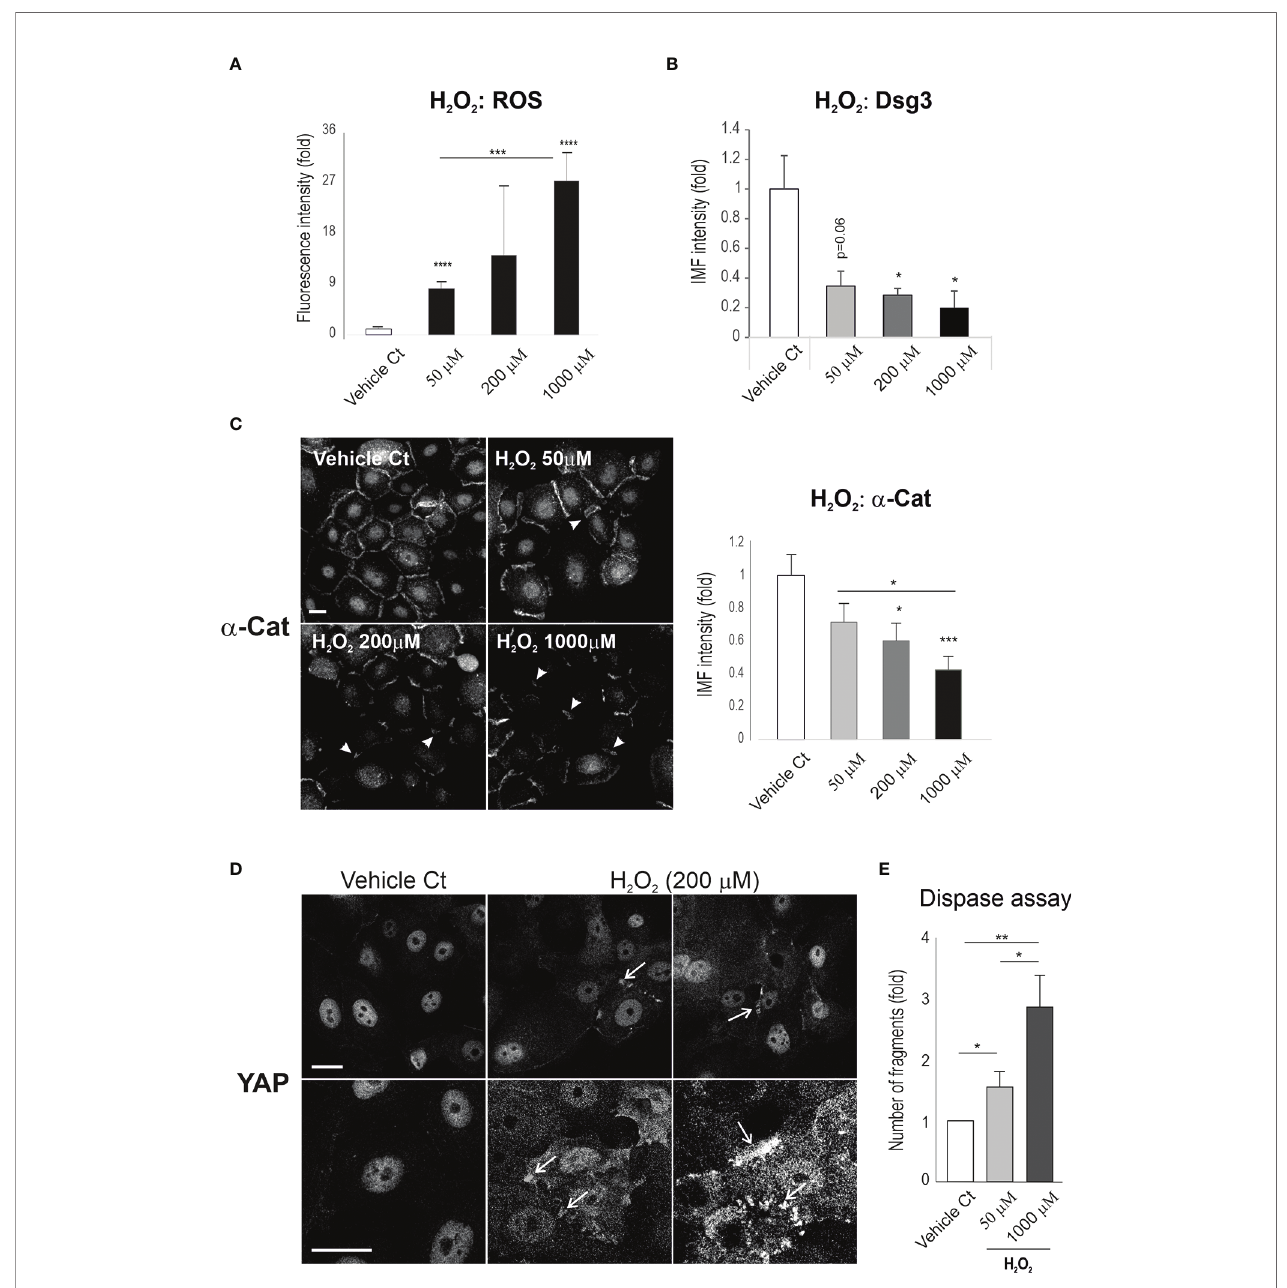
FIGURE 5 | H 2 O 2 treatment of keratinocytes causes a reduction of cell junction proteins with concomitant YAP accumulation in the cytoplasm and cell periphery. (A) A dose-dependent increase of ROS was detected in the cell populations treated with H 2 O 2 . Oral keratinocytes OKF4 were seeded at 5x10 4 per well in KSFM overnight to reach ~70% con fl uent densities in 96-well plate and then exposed to H 2 O 2 in KGM at elevated concentrations for 2 hours before treatment with CellRox reagent (5µM) for 30 minutes for ROS measurement. Images were acquired immediately with an INCA 2200 (n=14~16, at least 2 experiments) and analyzed with Developer Toolbox software. (B , C) Analysis of cell adhesion proteins Dsg3 and a -catenin indicated a dose-dependent decrease in their expression in cells treated with H 2 O 2 . Dsg3 staining was performed on coverslips with similar cell densities (5H10 mAb, n=5 fi elds/sample, 2 experiments) while a -catenin staining was conducted in 96-wells (n=25 automated images, 2 experiments, mean ± SEM). (D) Confocal images of YAP staining in cells of similar densities, treated with H 2 O 2